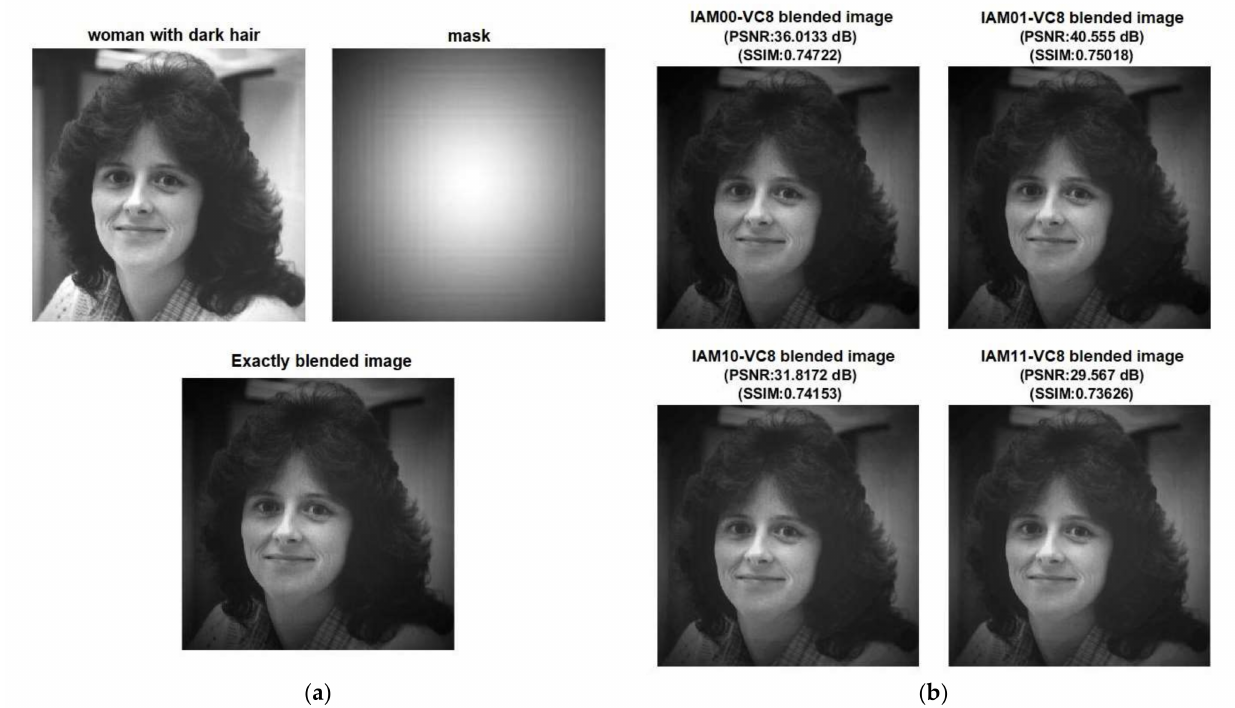
Figure 7. ( a ) Woman and mask images, and the exactly blended image. ( b ) Blended images obtained using various inexact array multipliers (IAM00-VC8, IAM01-VC8, IAM10-VC8, and IAM11-VC8) based on vertical cut VC8 made on the exact array